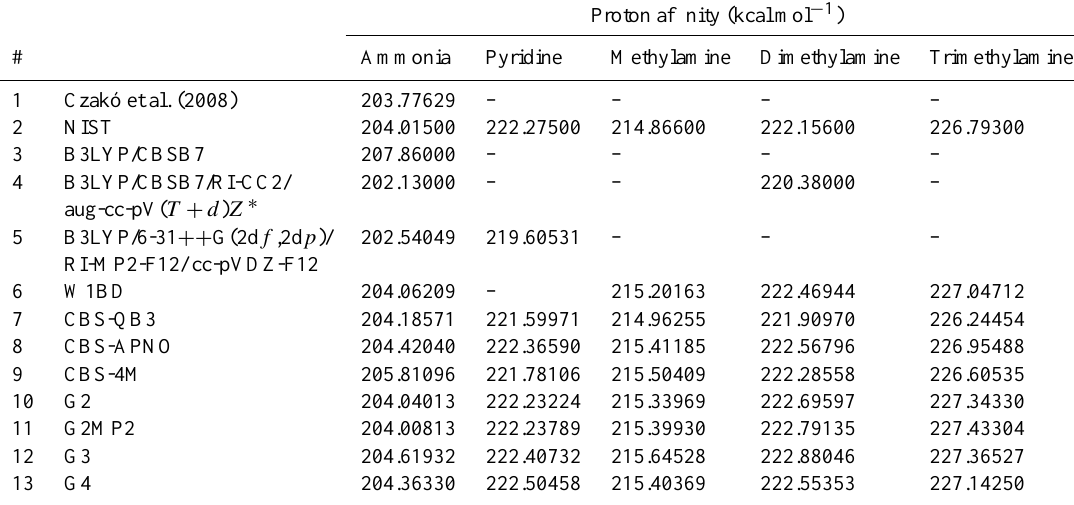
Table 1. An overview of the benchmark calculations. All values are in